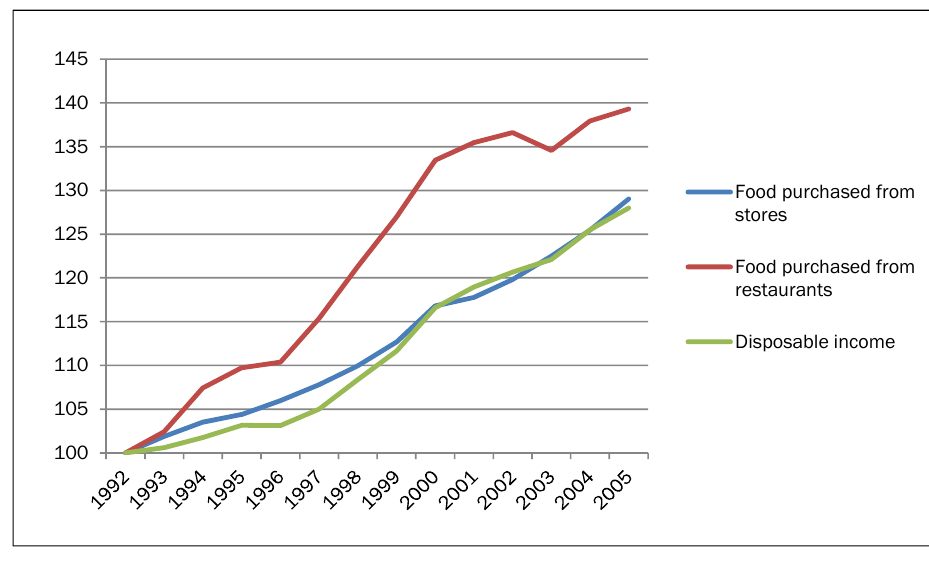
Figure 5. Real Food Spending and Disposable Income of Canadian Consumer, 1992–2005 (constant 1992